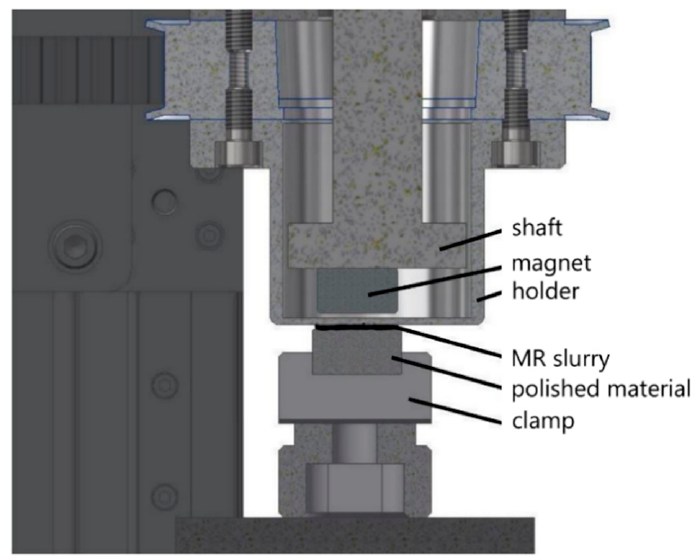
Figure 8. Polishing device used.